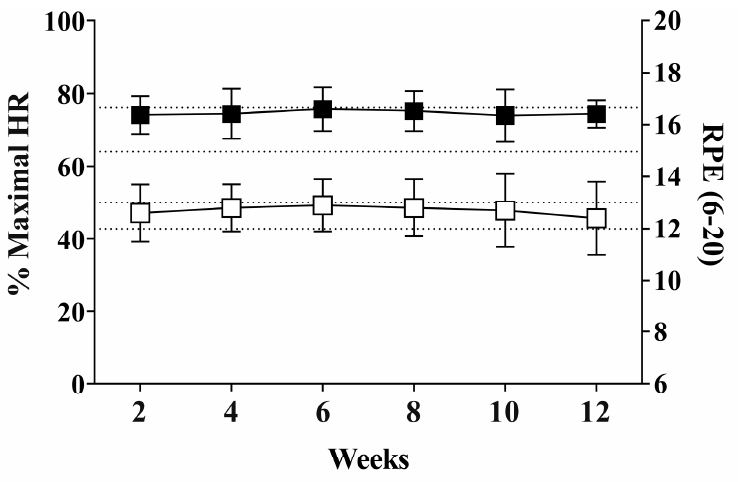
Figure 2. Heart rate (black square; left Y axis) and rating of perceived exertion (white square; right Y axis) responses during the 12-week physical activity counseling program. Dotted lines represent moderate intensity according to American College of Sports Medicine [33]: 64–76% of maximum heart rate (HR) and rating of perceived exertion (RPE) [12,13]. HR data of the participants under beta-blocker ( n = 7) were not included due to its effect on HR. Data are expressed as mean ± standard deviation.